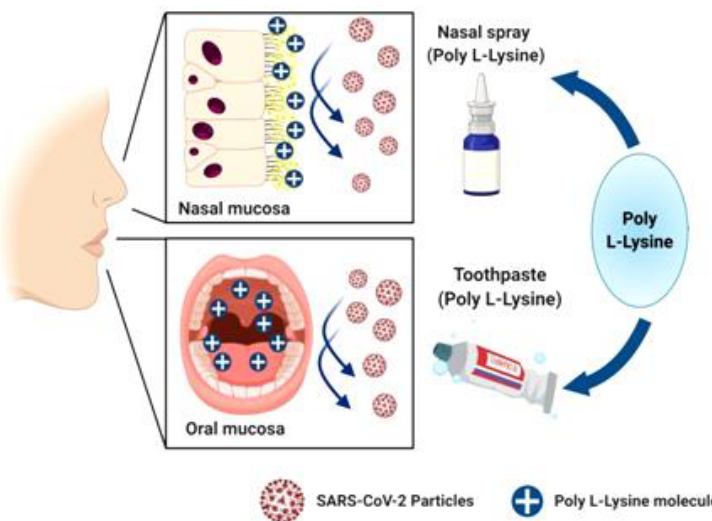
Figure 1. ε -Poly- L -lysine formulated in a toothpaste and a nasal spray can pose a new platform for COVID-19 prophylaxis. Created by Biorender.com.